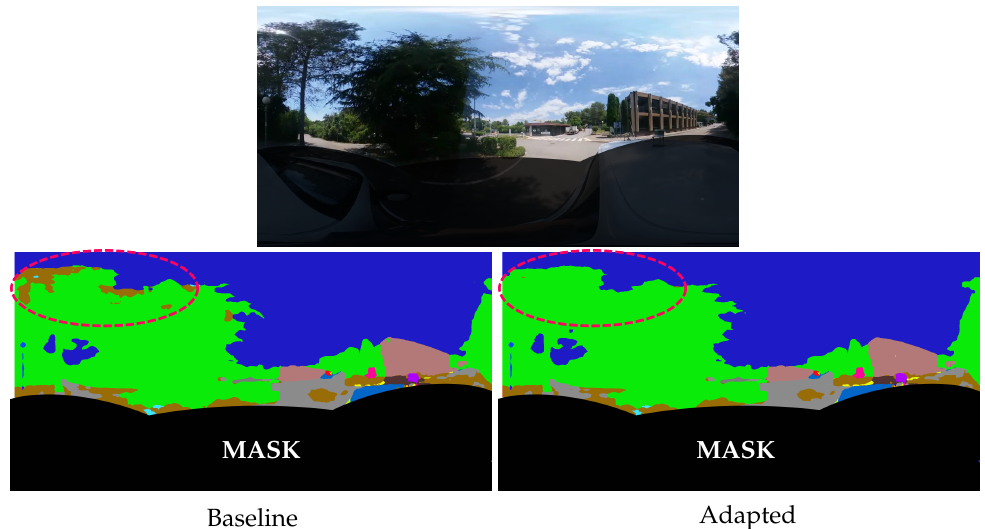
Figure 6. Urban driving example. The adapted network better identifies the tree canopy. A red circle at the top left of the image highlights the area with the most visible differences: the baseline network estimates the earth (in brown) class instead of trees (in